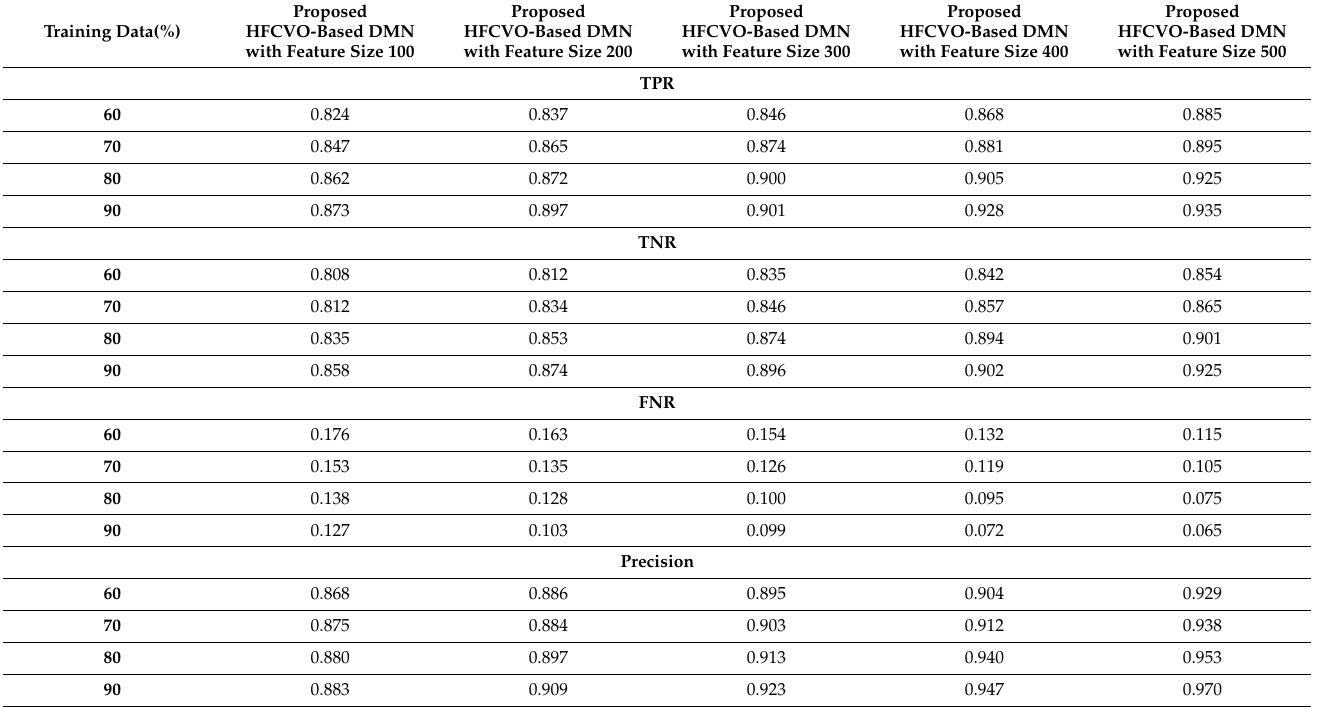
Table 2. Performance analysis using Reuter dataset for TPR, TNR, FNR, precision, and testing